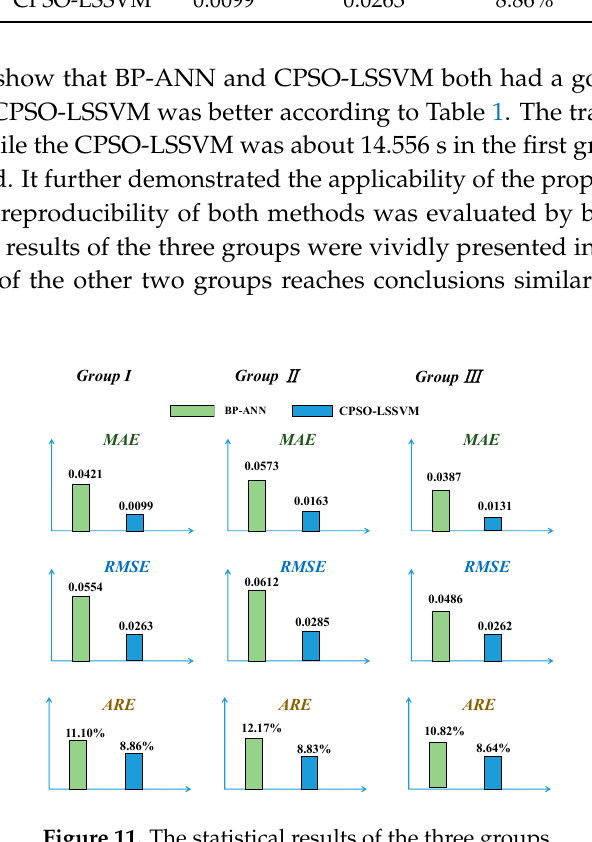
Figure 11. The statistical results of the three groups.